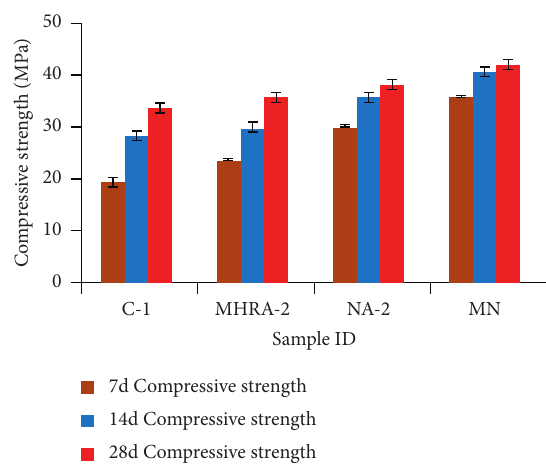
Figure 8: Compressive strength development.